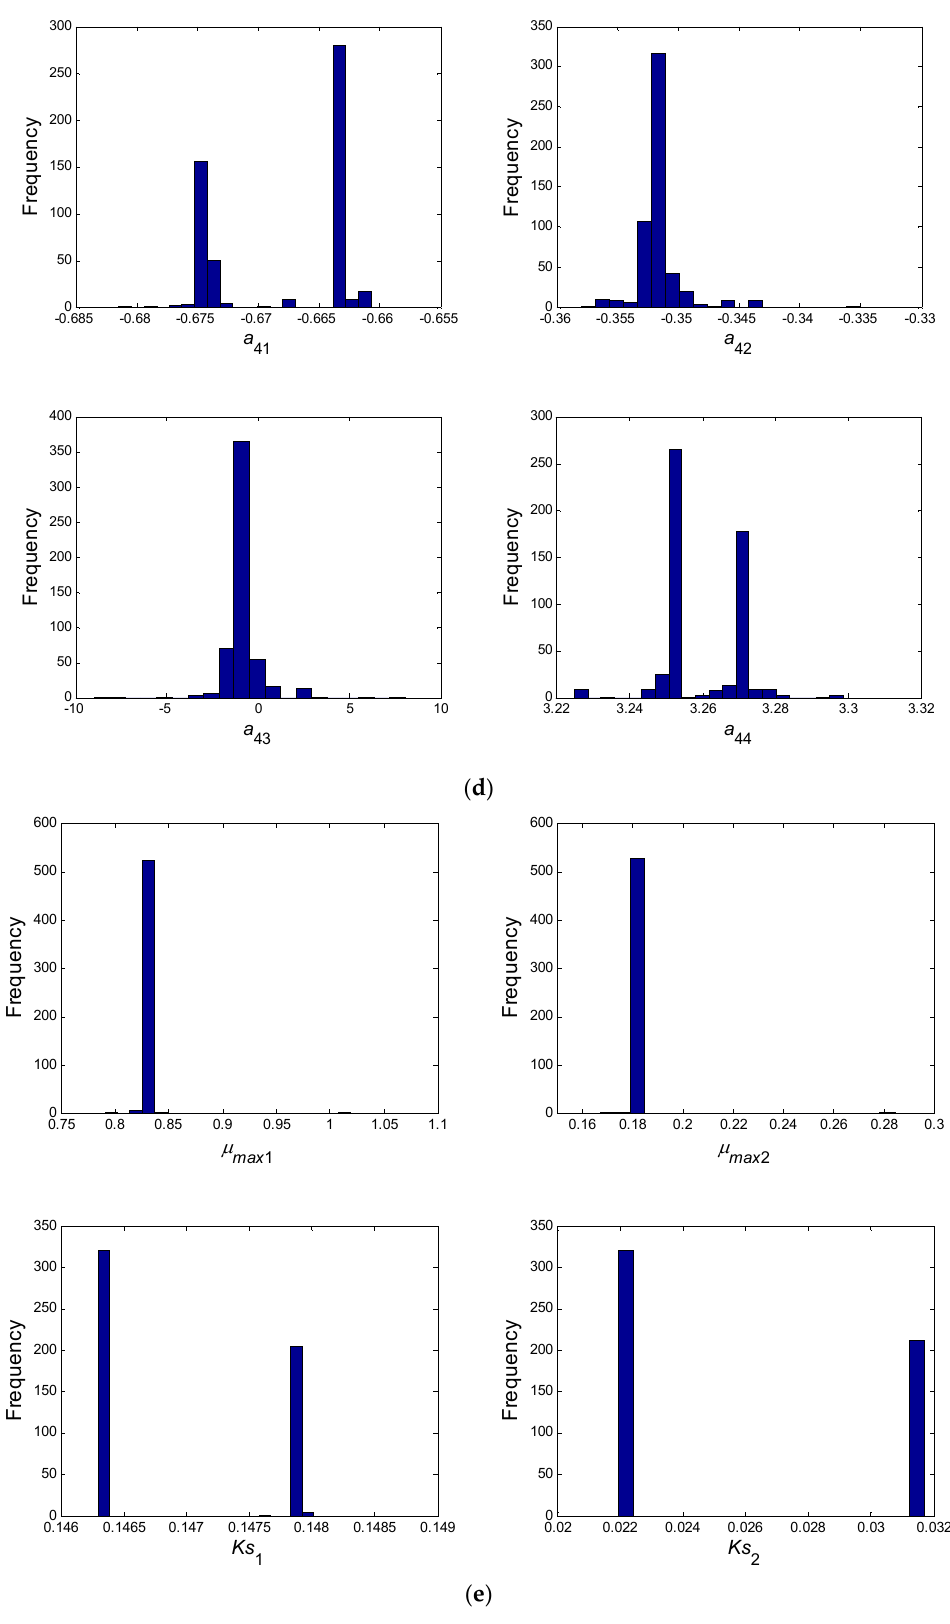
Figure 1. Distributions of the optimized interaction parameters for model #2 after Monte-Carlo-like optimization: ( a ) a 11 to a 14 ; ( b ) a 21 to a 24 ; ( c ) a 31 to a 34 ; ( d ) a 41 to a 44 and for the two ammonia oxidizing bacteria (AOB) and nitrite-oxidizing bacteria (NOB) of model #2 ( e ) µ max 1 , µ max 2 , K s 1 and K s 2